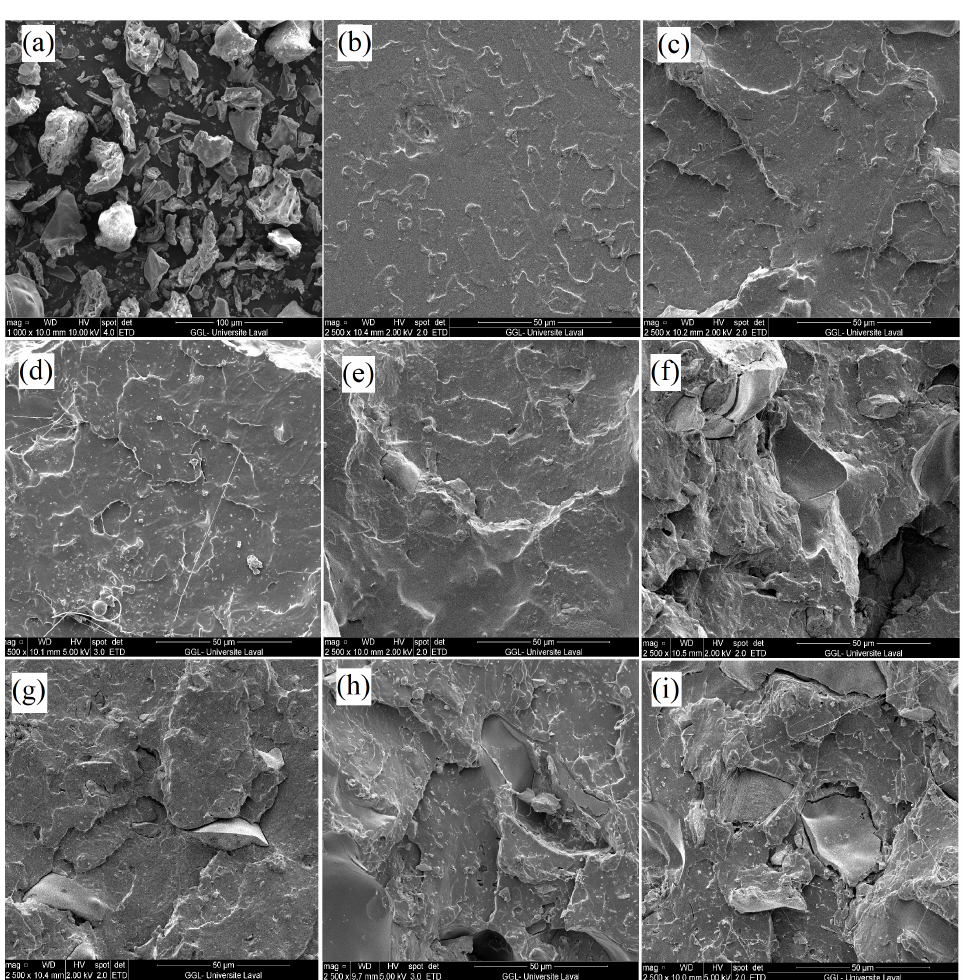
Figure 2. SEM micrographs of: ( a ) SiO 2 from rice husk, ( b ) neat PLLA, ( c ) PLLA/SiO 2 (95/5), ( d ) PLLA/SiO 2 (90/10), ( e ) PLLA/SiO 2 (85/15), ( f ) PLLA/SiO 2 /PEG (90/10/3), ( g ) PLLA/SiO 2 /PEG (90/10/5), ( h ) PLLA/SiO 2 /PEG (90/10/8), and ( i ) PLLA/SiO 2 /PEG